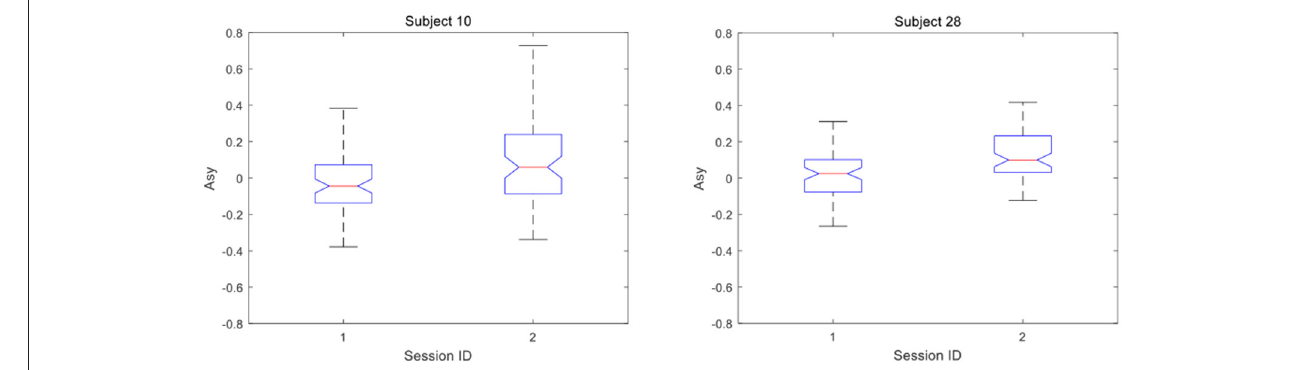
FIGURE 8 | Asymmetry index of subjects increases positively.